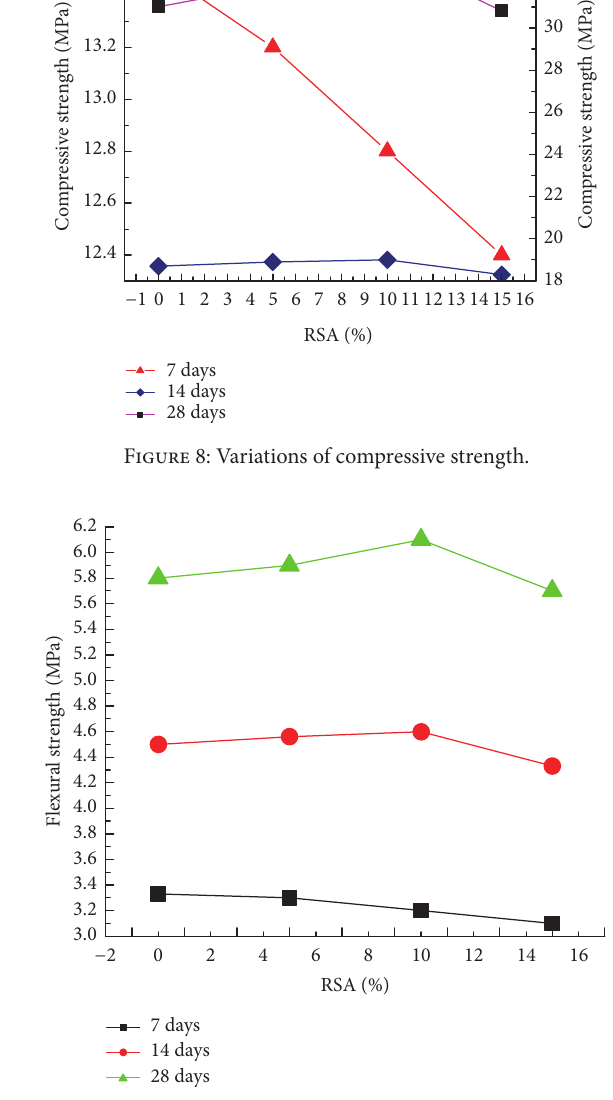
Figure 9: Variations of flexural